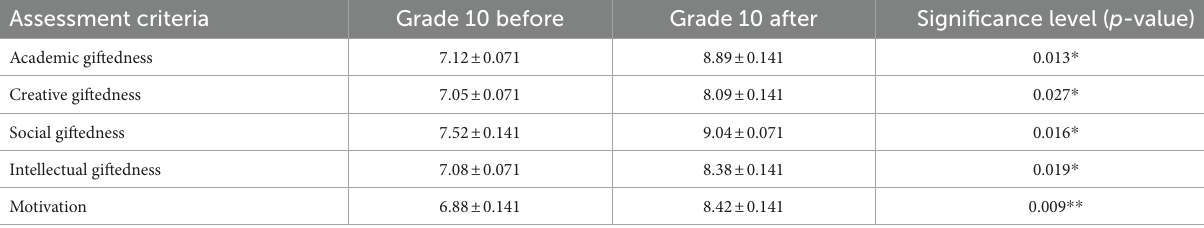
TABLE 5 Calculating class 10 results using student’s t -test. Assessment criteria Grade 10 before Grade 10